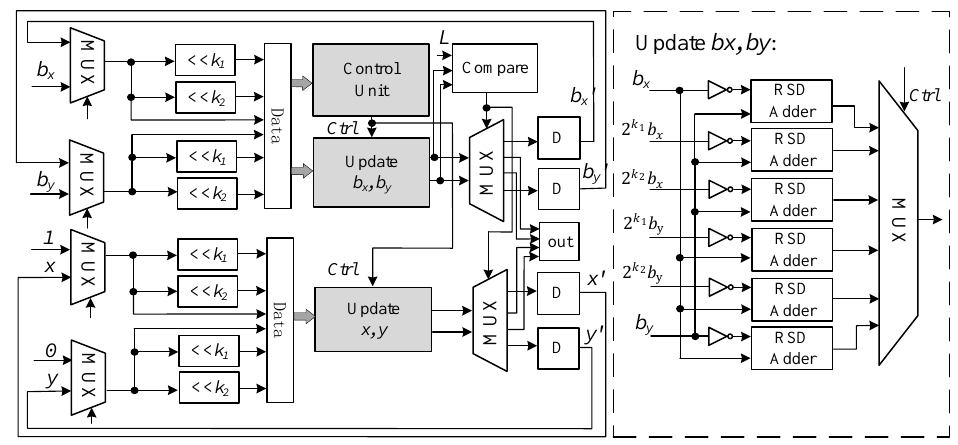
Figure 8: The architecture of the partial XGCD algorithm.